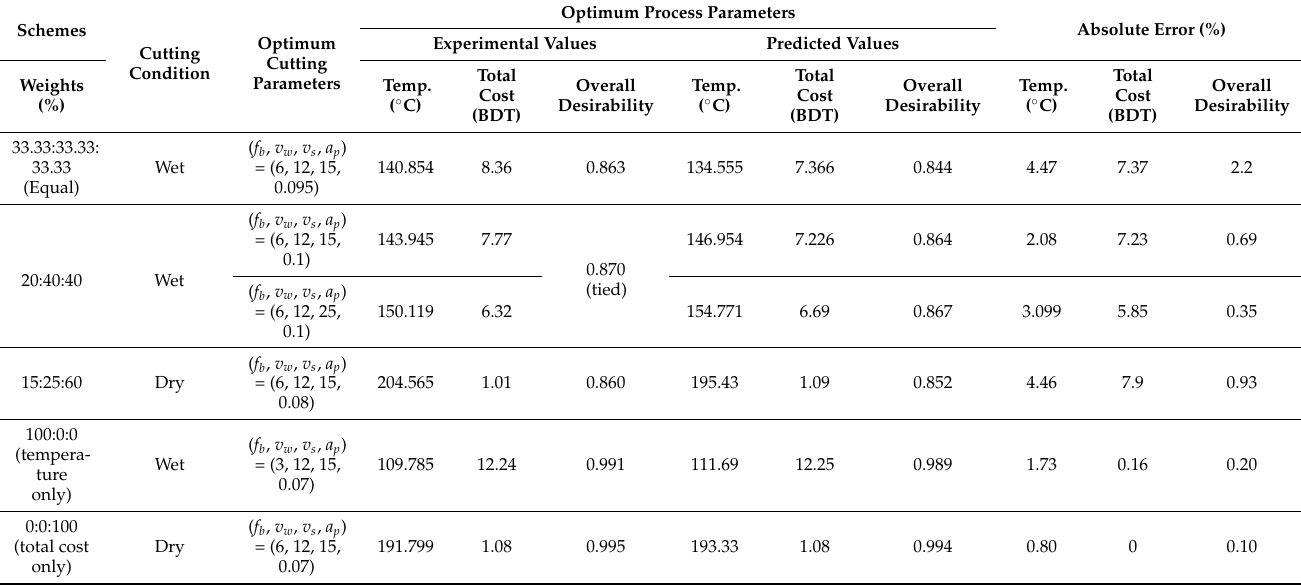
Table 9. Comparison of predicted and experimental responses using DFA